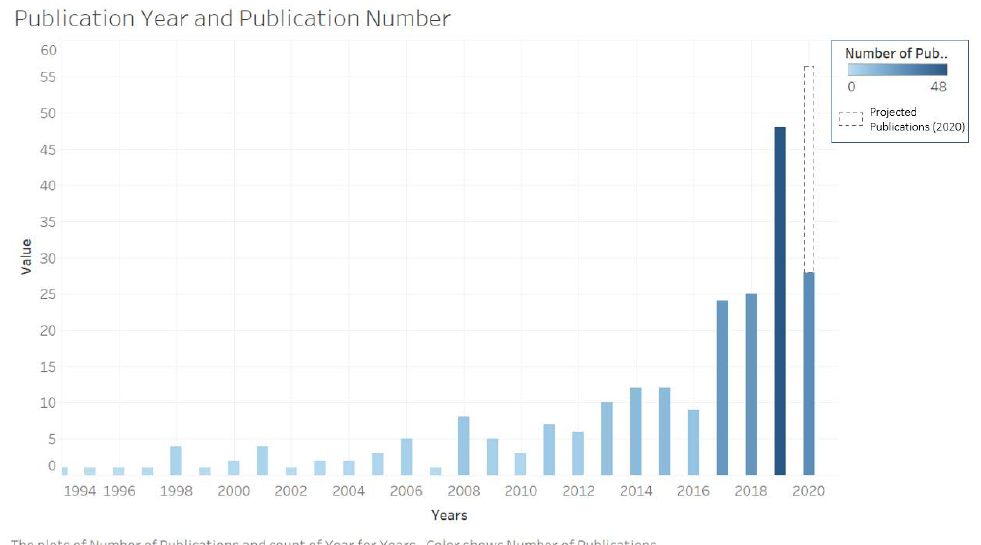
Figure 2. Total number of publications by year for studies related to digital phenotyping and patient-generated health data for outcome measurement in surgical care.